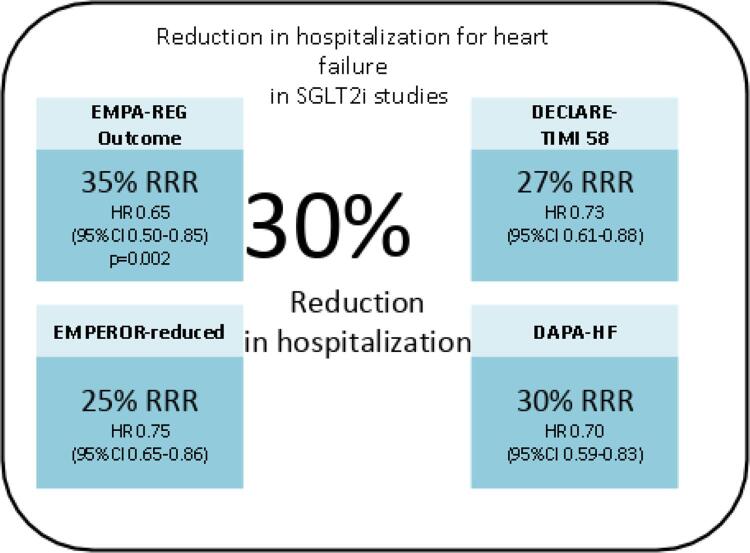
– Reduction in hospitalization for heart failure in SGLT2i studies. RRR: relative risk reduction.